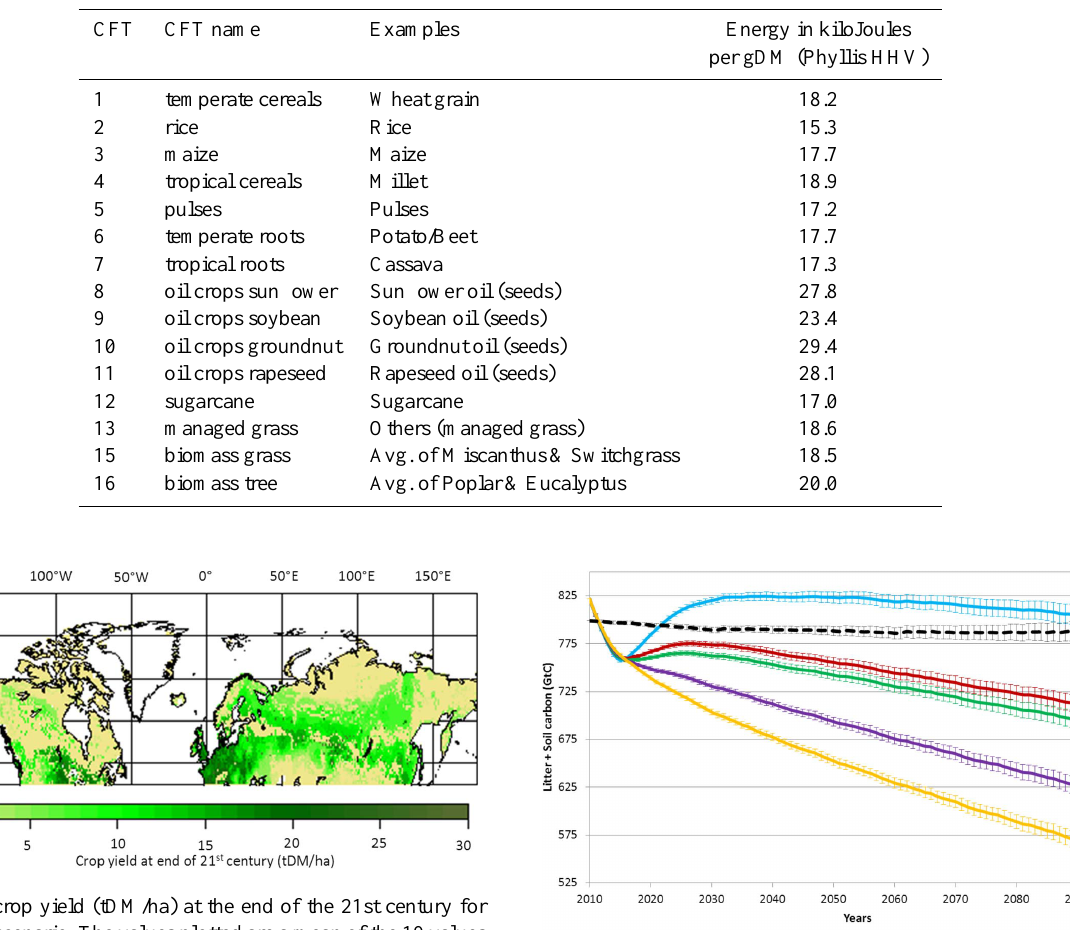
Table 2. CFTs of LPJmL and the primary energy per CFT (ECN, 2007).